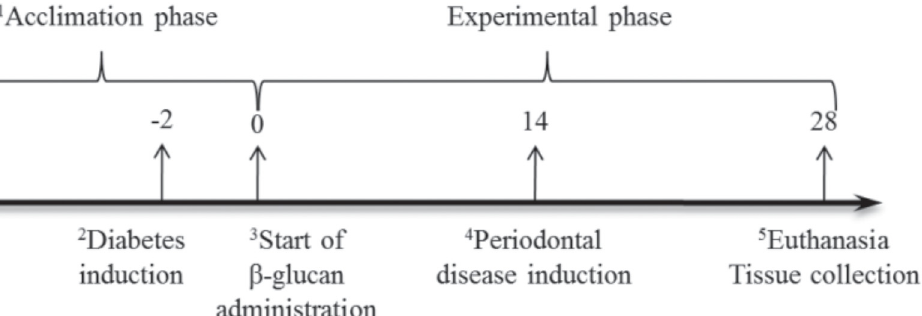
Fig 1. Schematic representation of the experimental design across time. 1 All animals were acclimated in individual metabolic cages for seven days; 2 For animals in the following groups: diabetes; diabetes + periodontal disease; diabetes + β -glucan; diabetes + periodontal disease + β -glucan; 3 For animals in the following groups: β -glucan; diabetes + β -glucan; periodontal disease + β -glucan; diabetes + periodontal disease + β -glucan; 4 For animals in the following groups: periodontal disease; diabetes + periodontal disease; periodontal disease + β -glucan; diabetes + periodontal disease + β -glucan; 5 Collection of blood samples and removal of the